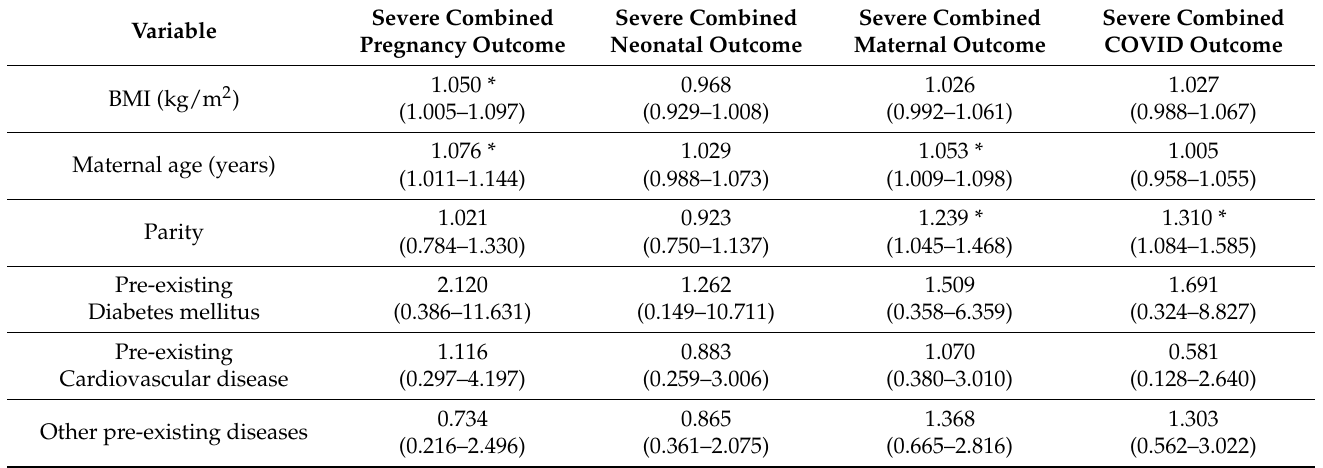
Table 4. Independent factors associated with the primary outcome parameters: severe combined pregnancy outcome, severe combined neonatal outcome, severe combined maternal outcome, severe combined COVID outcome ( n = 1037 included